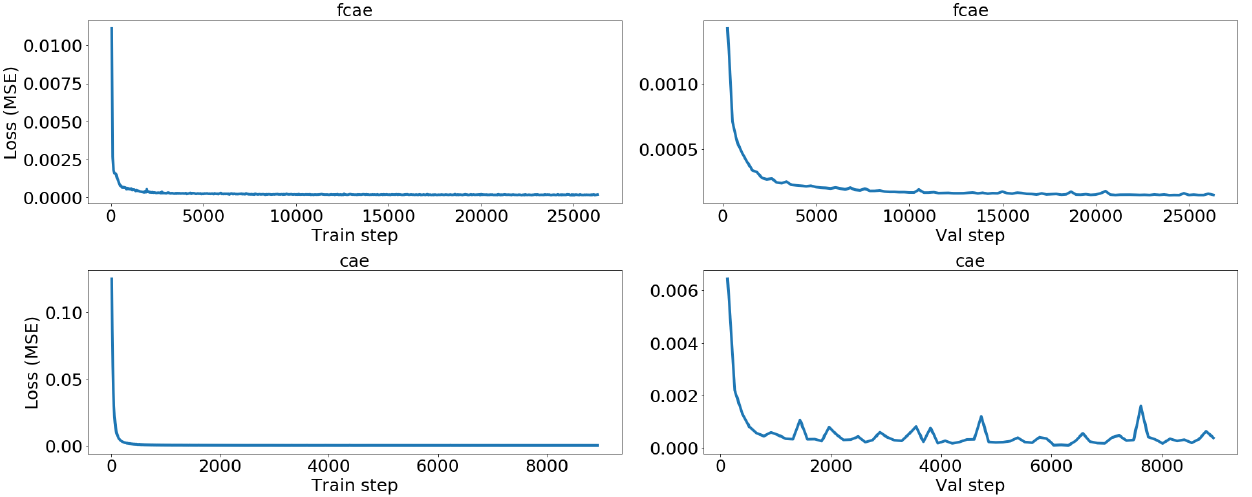
Figure 9. FCAE and CAE—Reconstruction loss (MSE) for the training ( left ) and validation ( right )